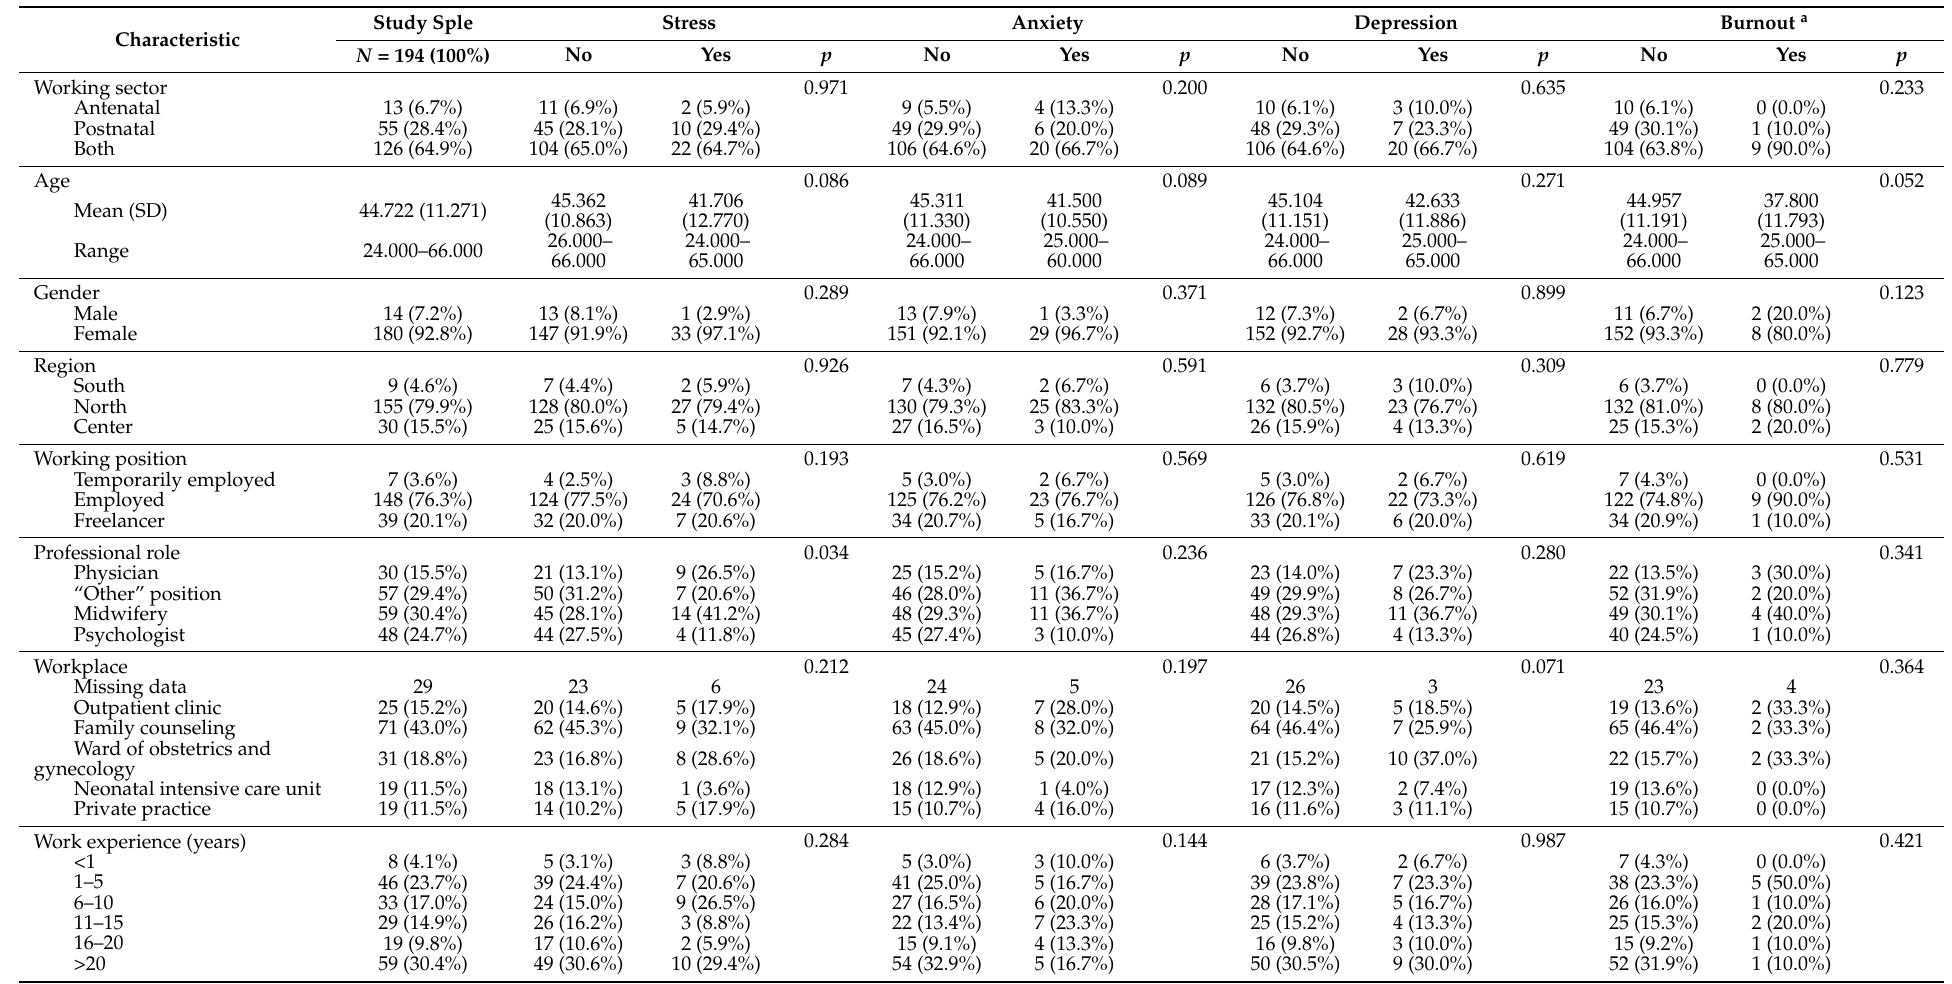
Table 2. Demographic and occupational characteristics of perinatal healthcare professionals, and prevalence of depression, anxiety, stress, and